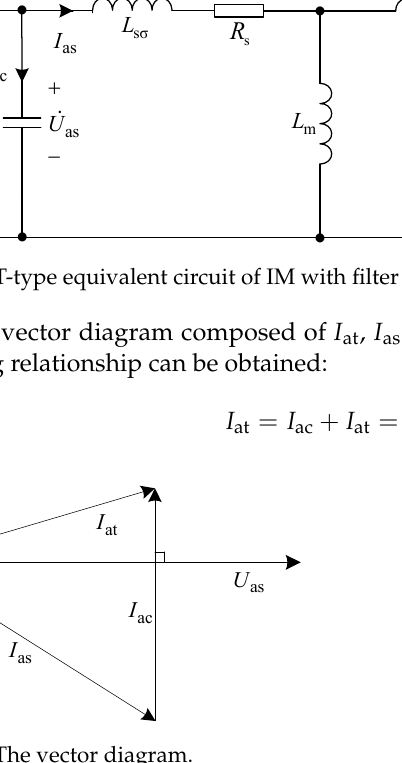
Table 1. The voltage of L dc and switching state in sectors II–VI.